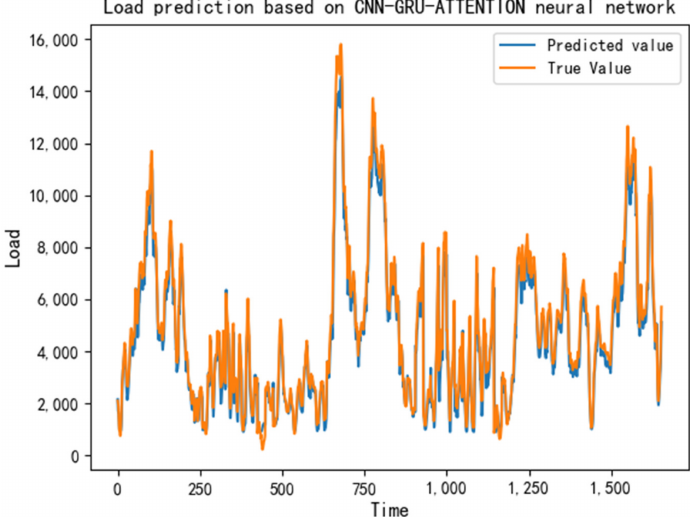
Figure 5. Load prediction based on CNN-GRU-ATTENTION neural